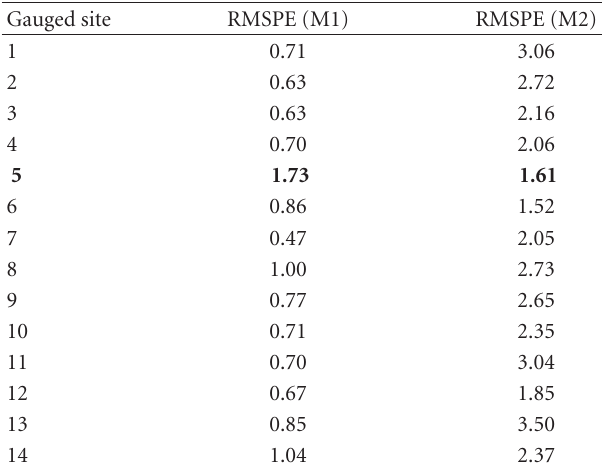
Table 1: The root-mean-square-predictive error (RMSPE) of the one-day-ahead prediction at fourteen gauged sites by using M1 and M2. M1 dominates M2 in all but 1